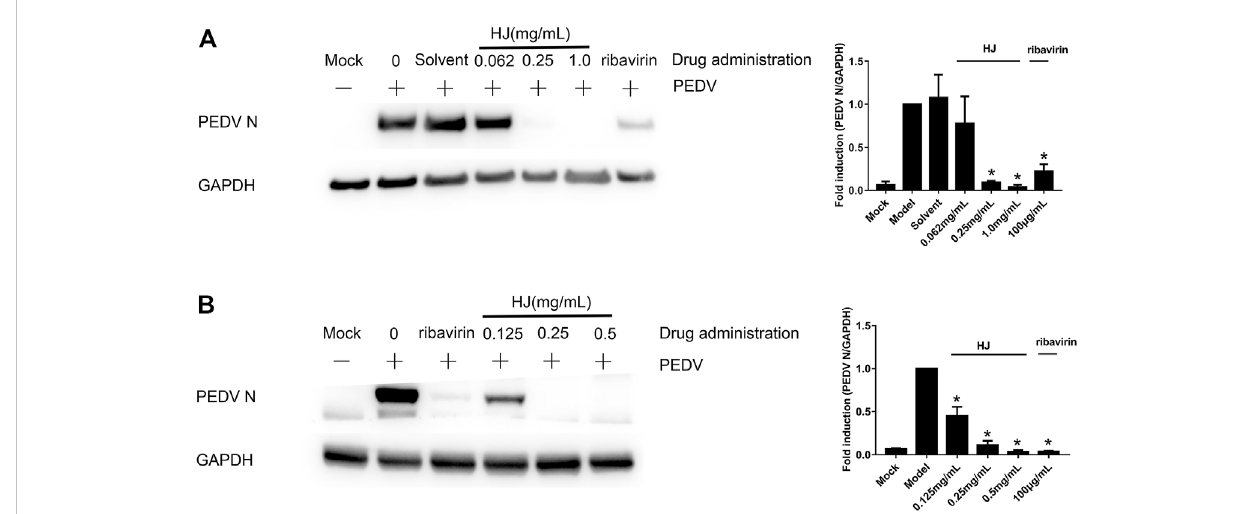
FIGURE 3 The expression level of PEDV N protein in Vero (A) or IPI-FX (B) cells were examined by western blot assays. Cells were treated with HJ throughout the experiment. The expression level of PEDV N protein was calculated in relation to the expression level of GAPDH at 24 hpi. Results are representative of three independent experiments. Data are represented as mean ± SD, n = 3. *, and p < 0.05 was considered statistically signi fi cant compared with the model group.